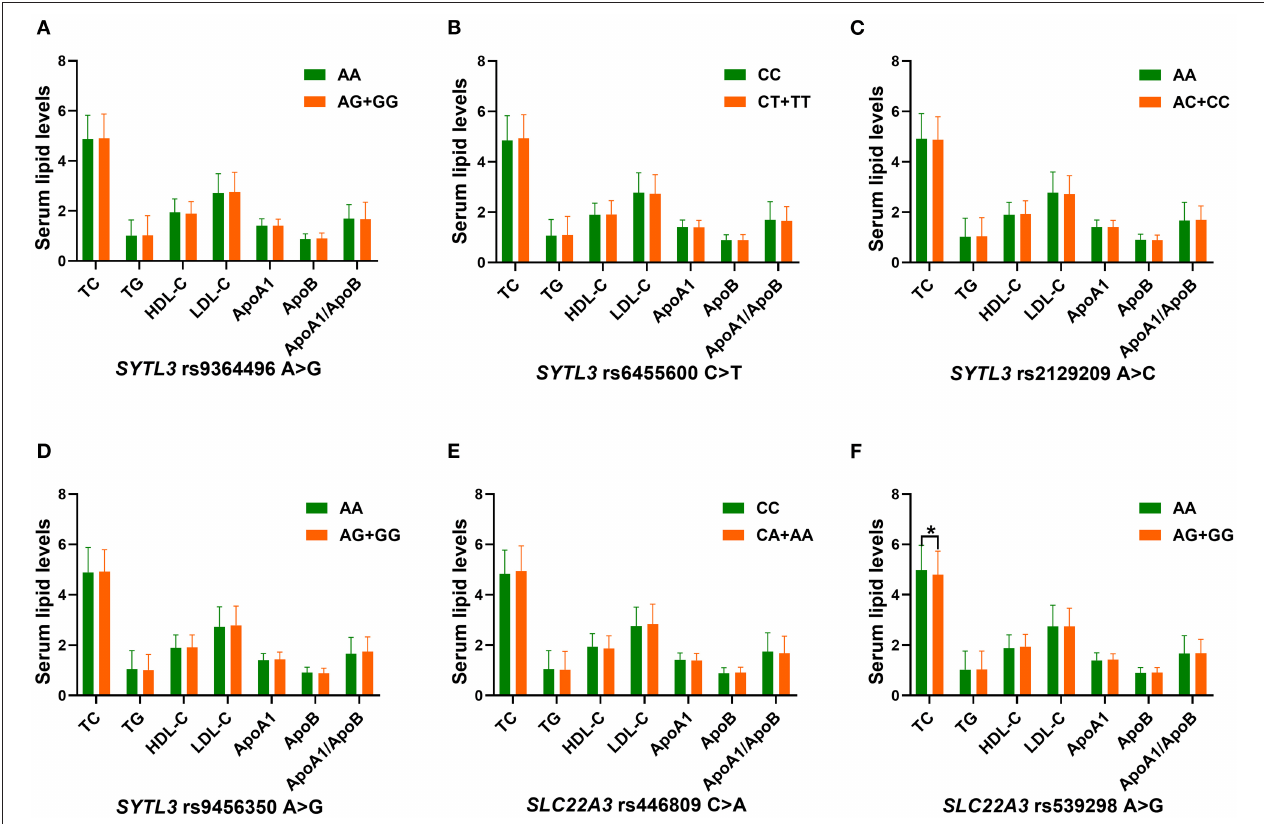
FIGURE 4 | The association between the genotypes of six SYTL3 - SLC22A3 SNPs and blood lipid levels in the control group. HDL-C, high-density lipoprotein cholesterol; TC, total cholesterol; ApoA1, apolipoprotein A1; TG, triglyceride; ApoB, apolipoprotein B; LDL-C, low-density lipoprotein cholesterol; ApoA1/ApoB, the ratio of apolipoprotein A1 to apolipoprotein B. A * P < 0.008 (after adjusting for 6 independent tests by the Bonferroni correction) was considered statistically significant. (A) , rs9364496; (B) , rs6455600; (C) , rs2129209; (D) , rs9456350; (E) , rs446809; and (F) , rs539298